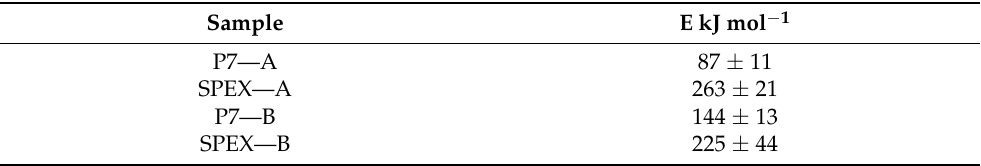
Figure 7. Kissinger linear fitting to calculate the activation energy of the crystallization process (experimental point for each sample are linked to peak temperatures of samples determined at 10, 20, 30, and 40 K/min from right to left respectively). Coefficients of correlation R-squared > 0.9. Table 6. Apparent activation energy of the crystallization process.